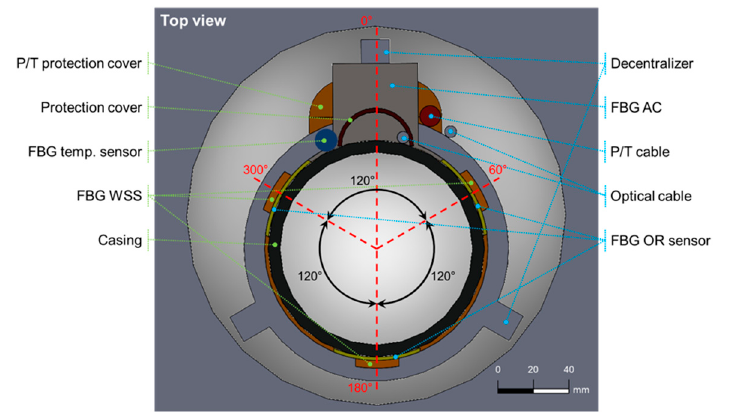
Figure 3. Top view schematic of sensor casing deployed inside borehole.